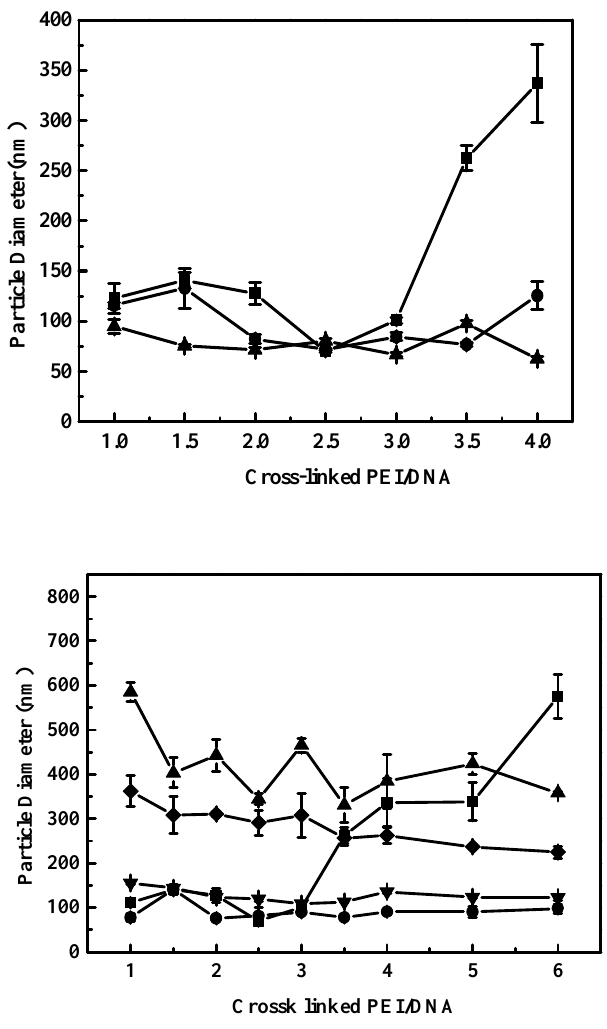
Figure 2. Dynamic light scattering of polymer/DNA polyplexes. 30 µ g of DNA in 750 µ l ddH